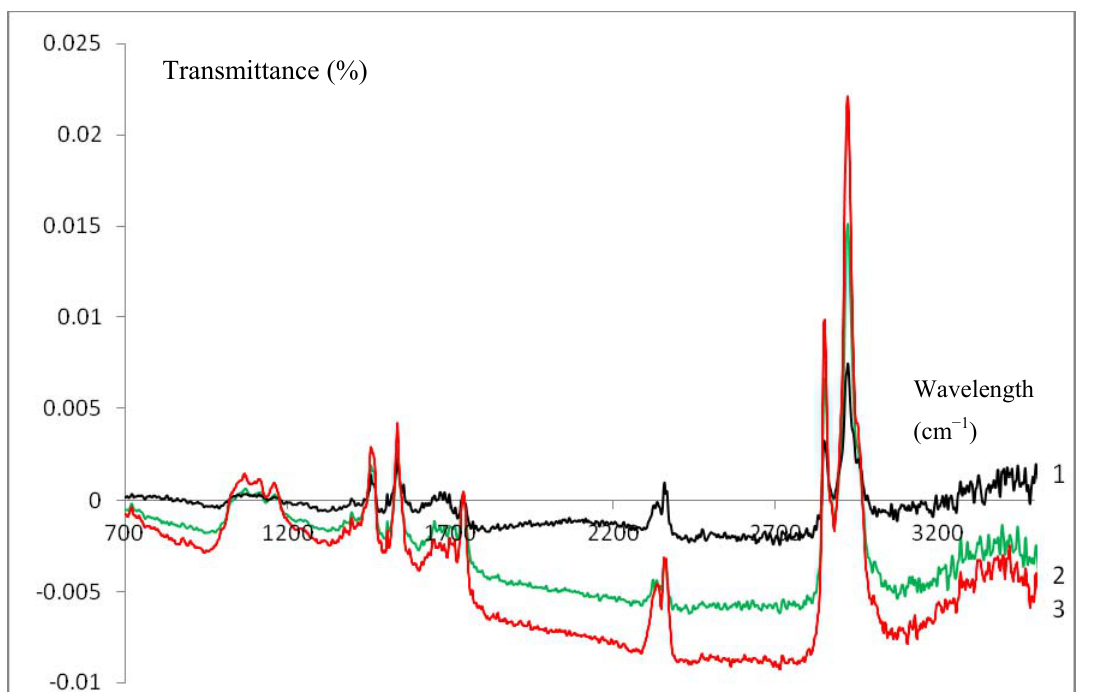
Figure 4. ATR-IR spectra of a spin coated GelB|C (black, 1), Cat|GelB|C (green, 2) and HHC|GelB|C (red, 3) electrode after background